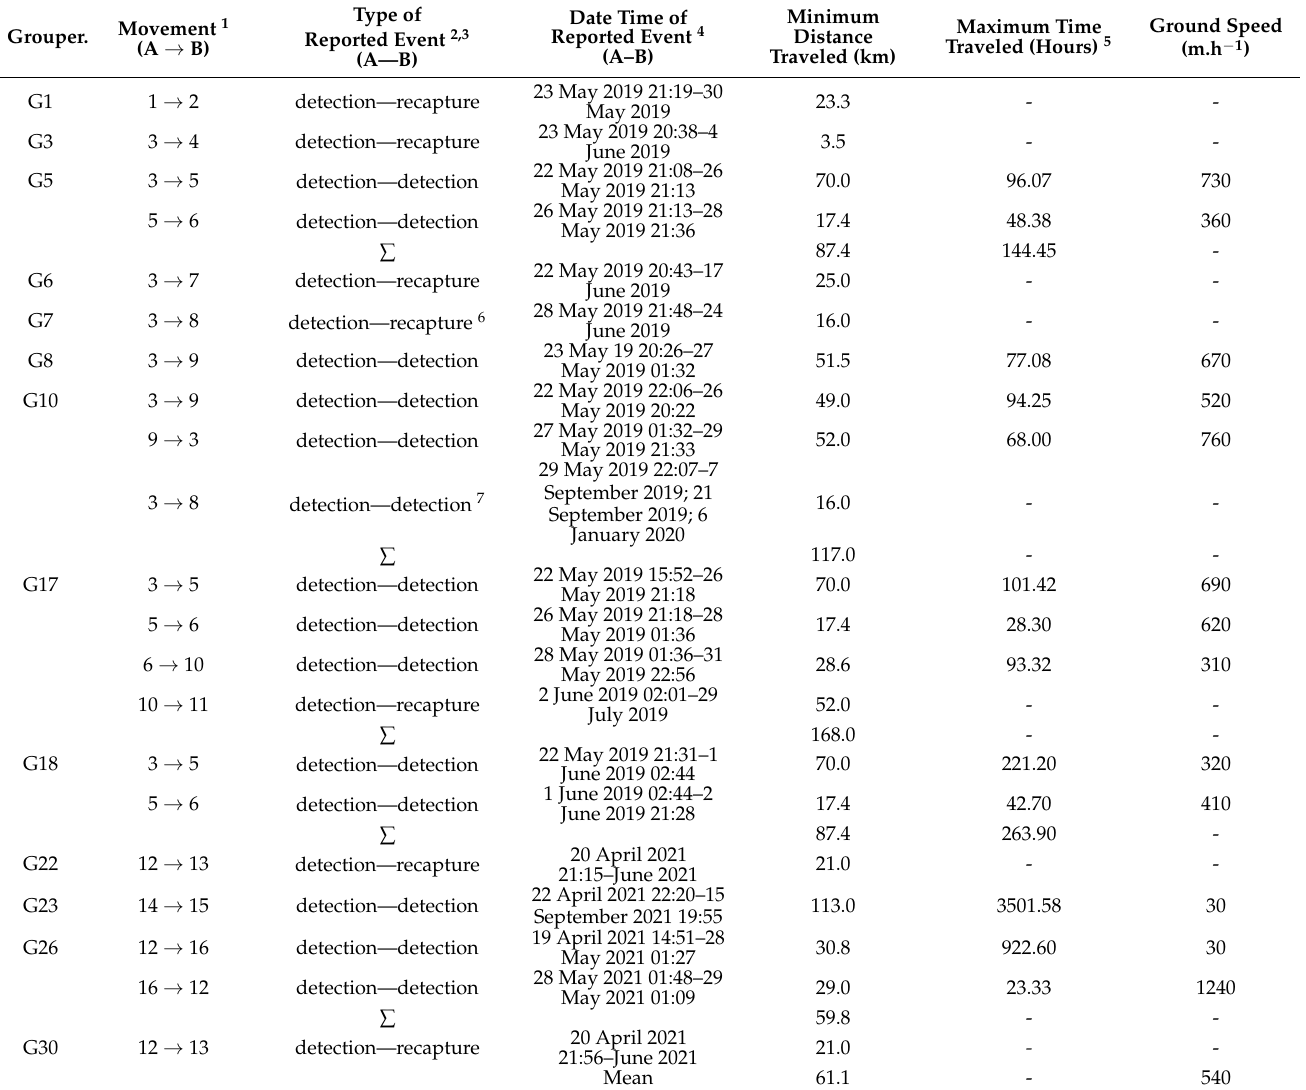
Table 6. Descriptive data of dusky groupers’ long-distance ranging movements along the coast, reported through a combination of detections with acoustic biotelemetry (passive or active tracking) and recaptures (by professional or recreational fishers) after leaving the no-take